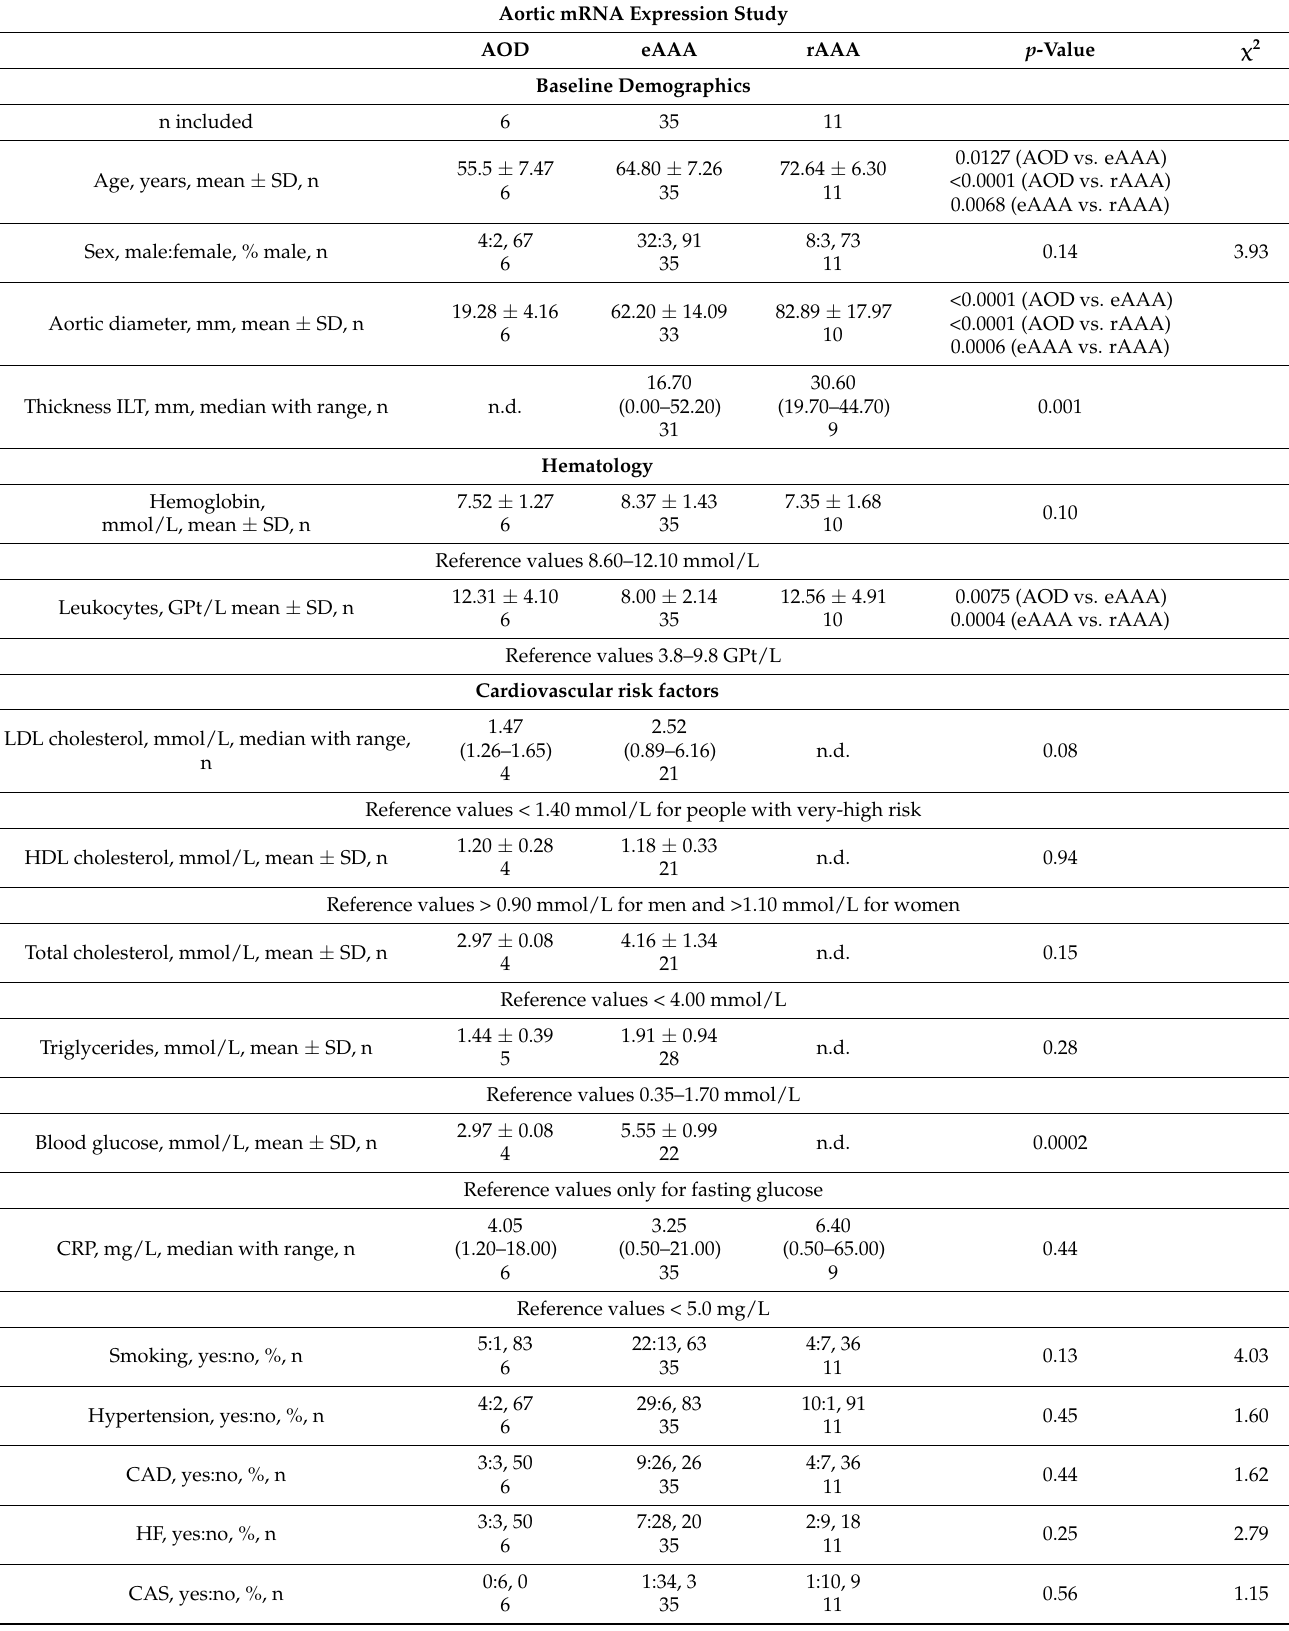
Table 1. Clinical characteristics of patients with abdominal aortic aneurysm (AAA) and arterial occlusive disease (AOD) for analysis of aortic mRNA